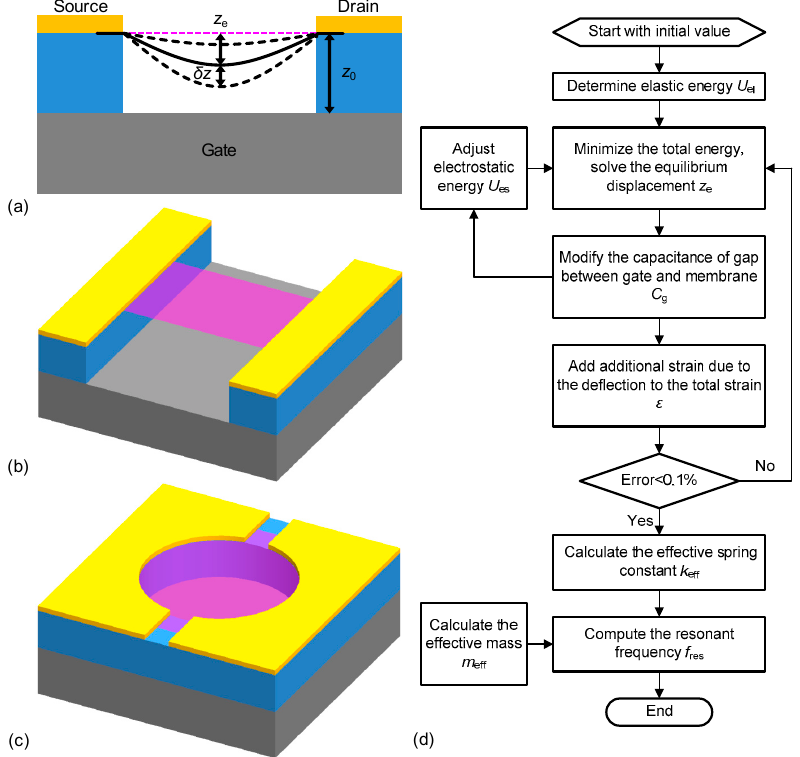
Figure 1. Device structures and modeling procedure of electrostatic tuning of resonance frequency in graphene nanoelectromechanical systems (NEMS). ( a ) Deflection of graphene resonator under electrostatic force. Without gate voltage, the membrane is flat (thin magenta dashed line) and suspended over the trench at equilibrium. With applied DC gate voltage, the membrane deflects to new equilibrium displacement z e (thick black solid line). With AC actuation, the membrane vibrates with amplitude δ z (thick black dashed lines). ( b , c ) Schematics of doubly clamped and circular drumhead graphene resonators, respectively. ( d ) Flowchart for computational implementation of the frequency tuning model.